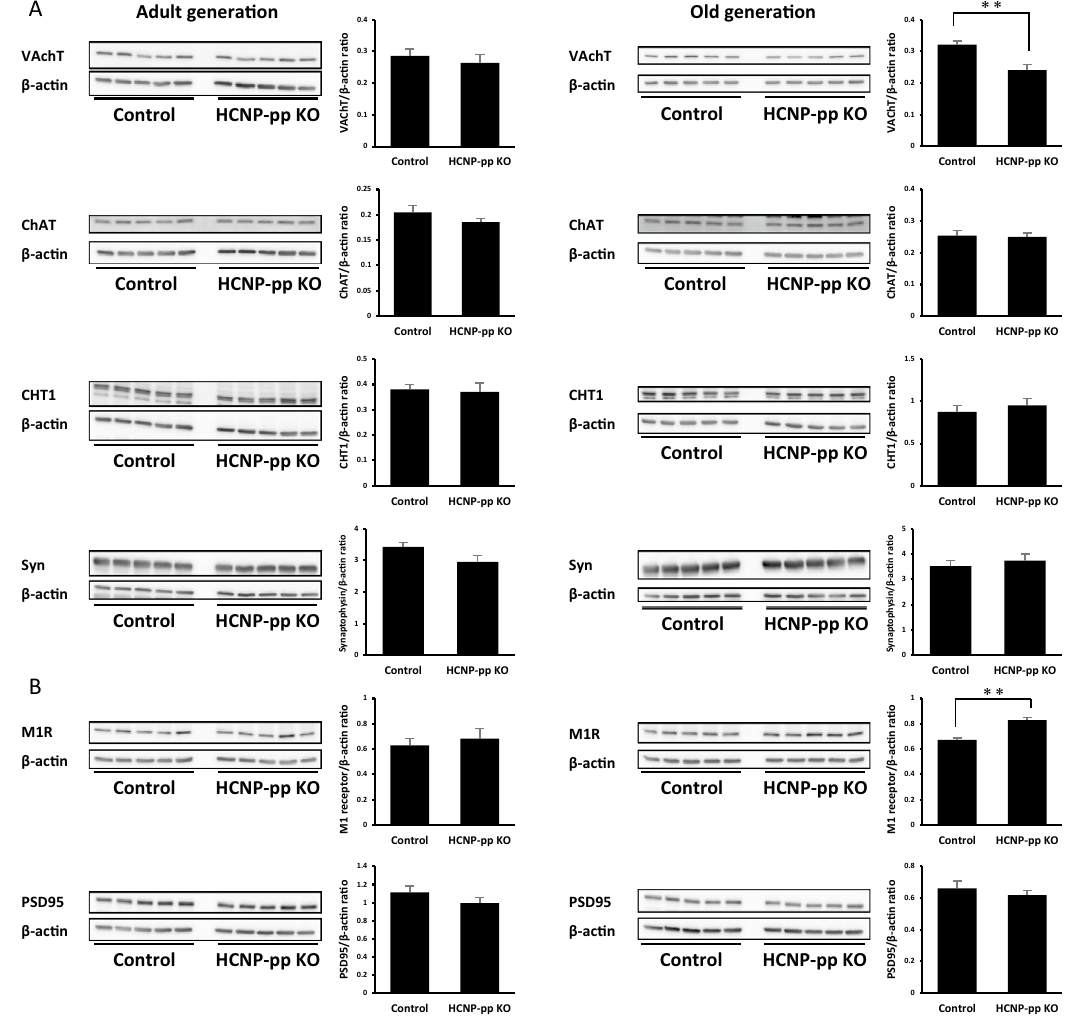
Figure 3. The evaluation of molecules related to cholinergic synaptic function screened using western blots. ( A ) Choline acetyltransferase (ChAT), vesicular acetylcholine transporter (VAchT), high-affinity choline transporter (CHT1), synaptophysin, ( B ) muscarinic M1 receptor evaluated as molecules related to cholinergic synaptic function. ( A and B left panel) The adult generation of hippocampal cholinergic neurostimulating peptide- precursor protein knockout (HCNP-pp KO) mice and age-matched control mice. ( A and B right panel) The old generation HCNP-pp KO mice compared to the age-matched control mice ( p < 0.01). Five HCNP-pp KO mice and five age-matched control mice were examined in each generation. The β-actin as internal standard in each blot was subsequently assessed on the same sheet (Fig. S2). The data are presented as the mean ± standard error of the mean. * p < 0.05. ** p <